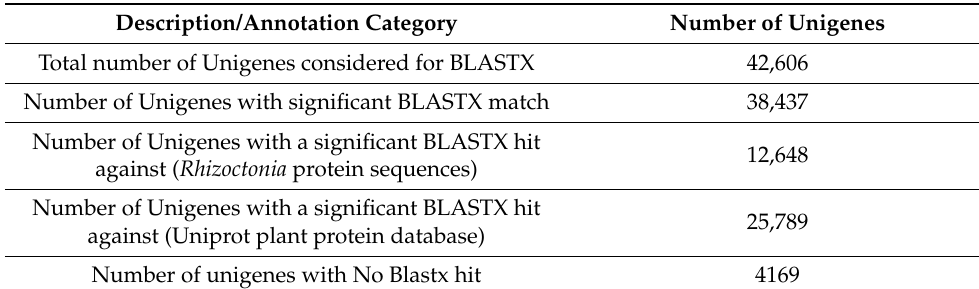
Table 2. BLASTX, UniProt, and Unigene Annotation